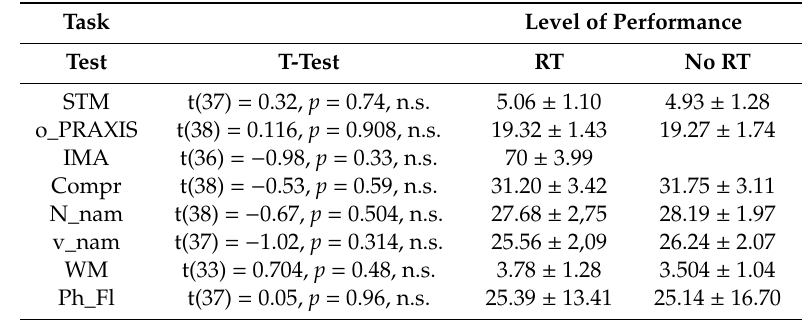
Table 7. E ff ect of performing radiotherapy post-recurrent surgery: comparison of performance between patients who did and did not undergo